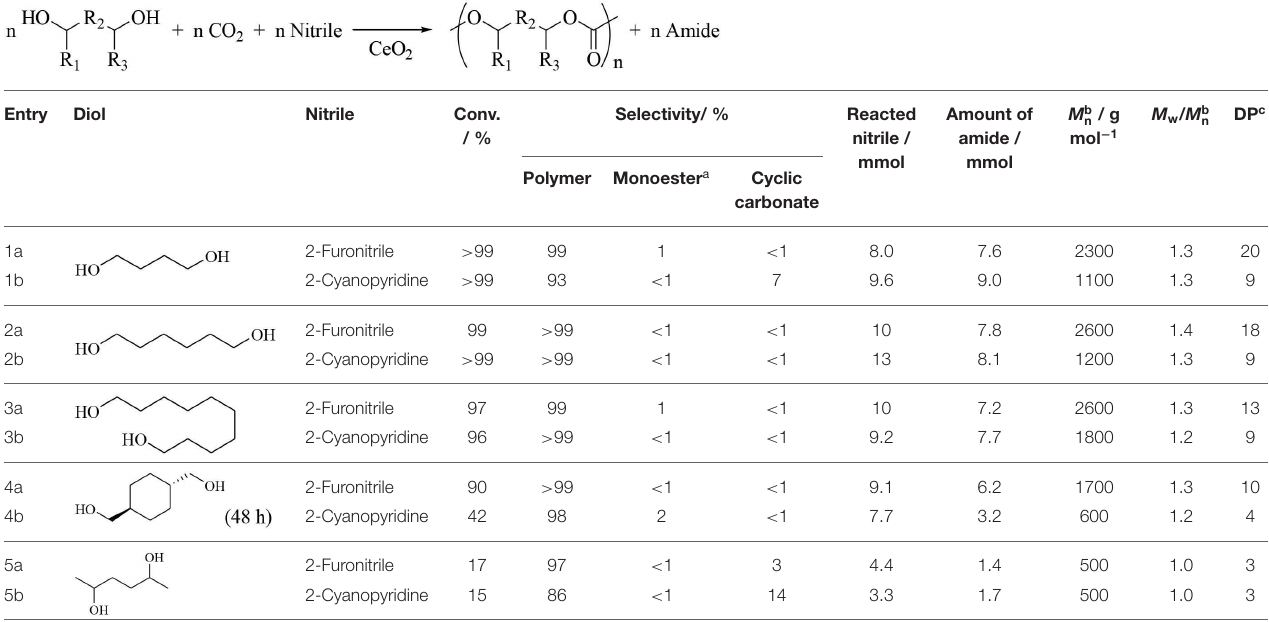
TABLE 7 | Comparison between 2-cyanopyridine and 2-furonitrile in copolymerization of CO 2 and diols on CeO 2 (Gu et al., 2019b).